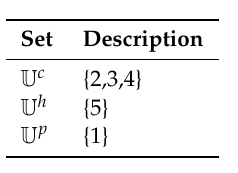
Table A3. Sets used test instance 2.